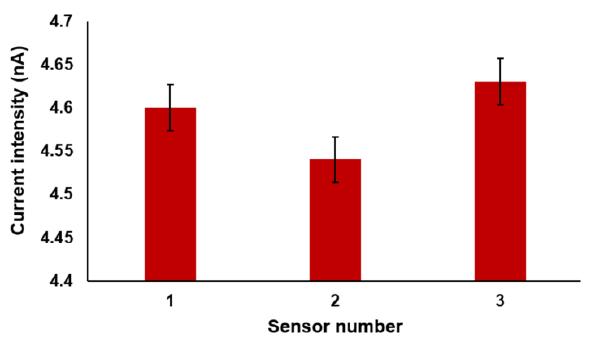
Figure 9. Reproducibility of the Fe(TPFPP)Cl/AuNPs-S-Gr sensor.